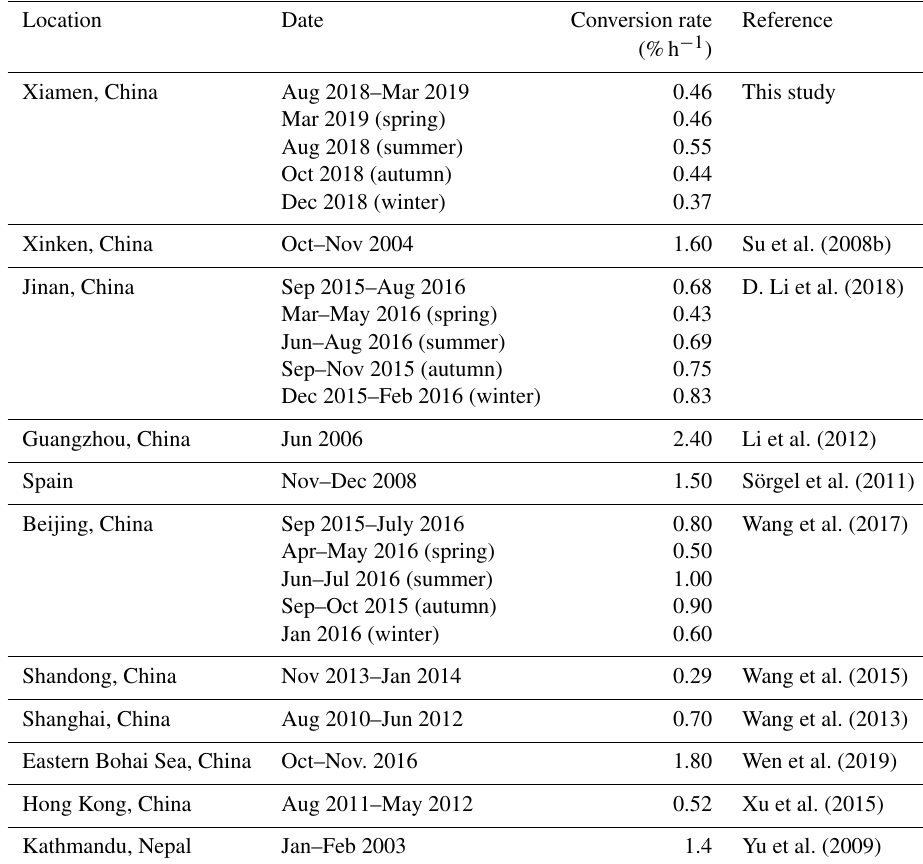
Table 3. Overview of the conversion frequencies from NO 2 to HONO in Xiamen and comparisons with other studies.